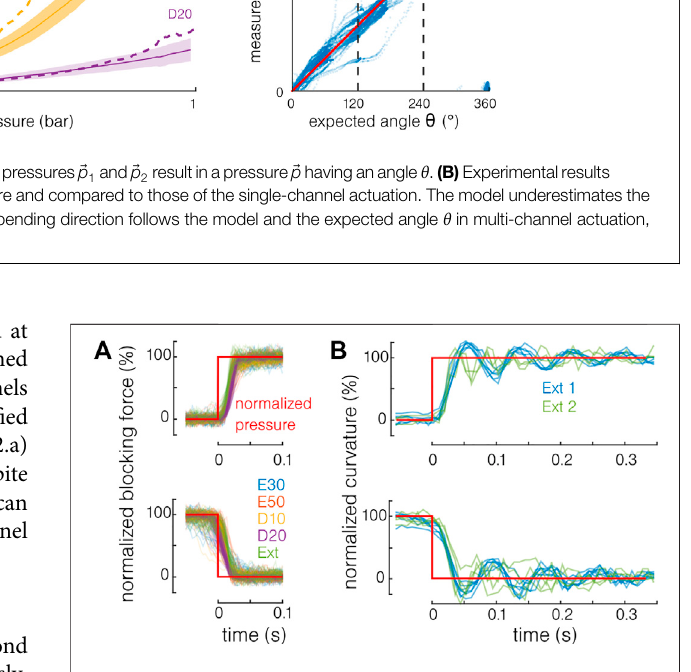
FIGURE 9 | Response time of the actuator. (A) In blocking force, no difference is observed between the different materials. (B) In bending, the response time remains in the same order of